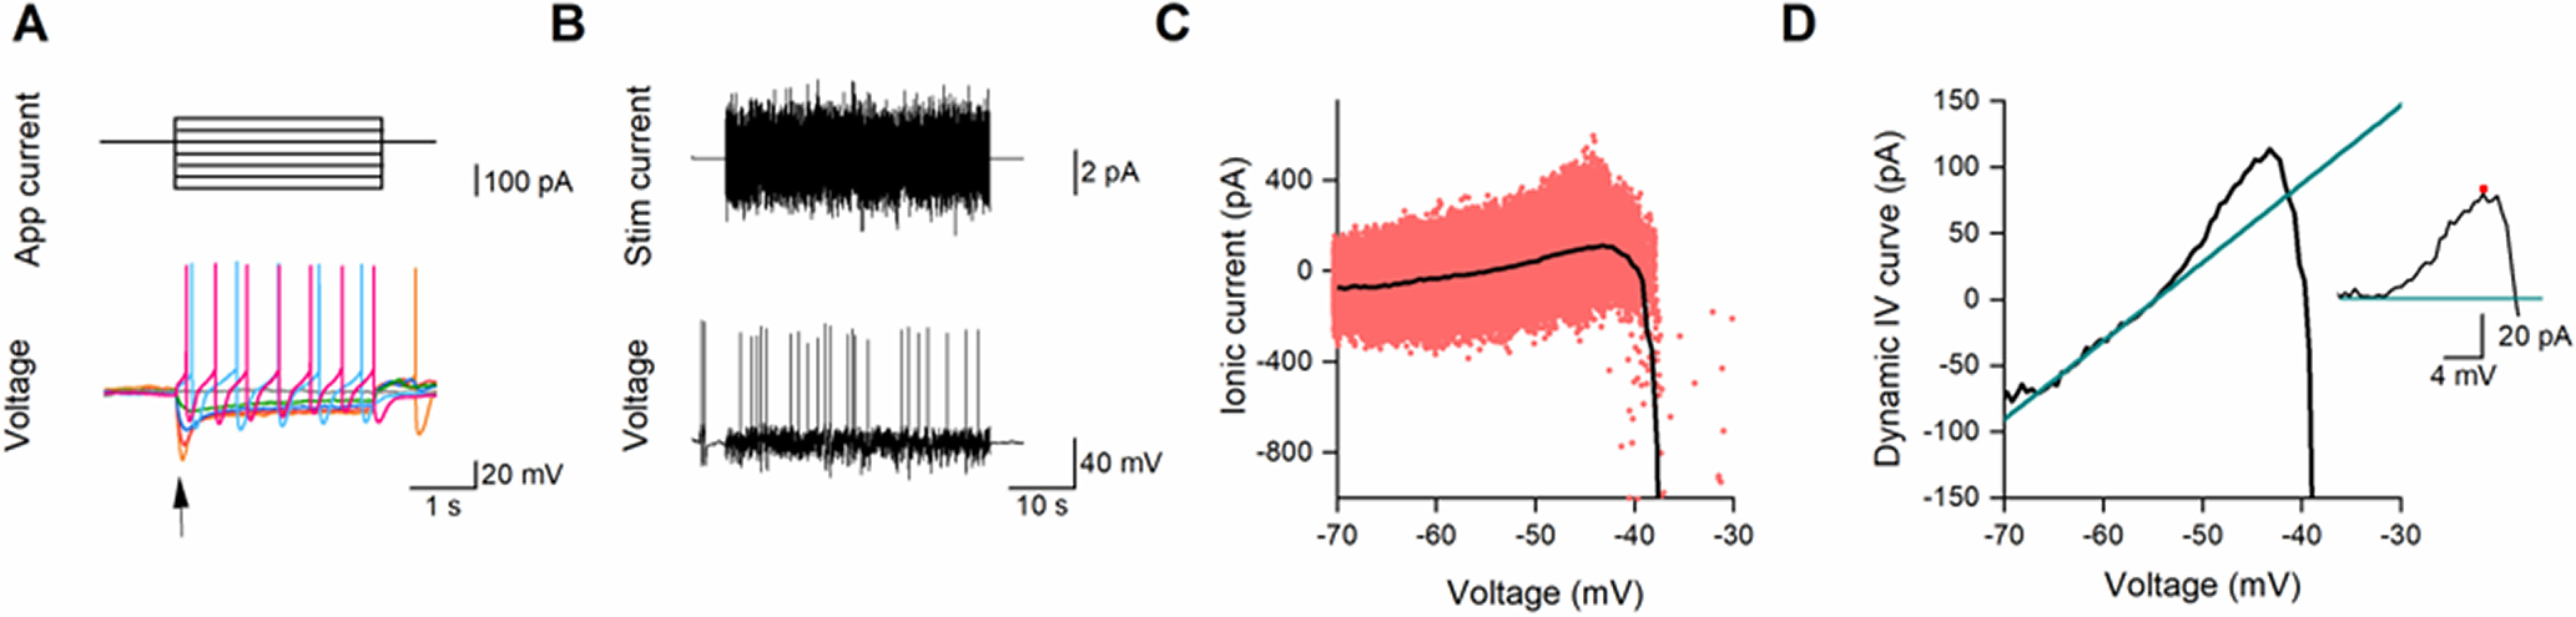
Extracting neuronal parameters using SIV (A) and DIV (B–D) methodologies. For the SIV measurements: (A) applied current and voltage response. Arrow shows location of voltage measurement for the calculation of neuronal resistance (peak voltage deflection). For the DIV measurements: (B) naturalistic stimulation current and voltage response. C, The estimated ionic current as a scatter plot against voltage (points). The DIV curve (black) is the typical ionic current at a particular voltage where data within 200 ms postspike was not included to avoid the effects of transitory spike-generated currents. D, The DIV curve (black) and its linear fit to the ohmic component (green, from hyperpolarized voltages to the resting voltage). Inset, Isolated outward current. For further details of the SIV and DIV fitting procedures, see Materials and Methods.